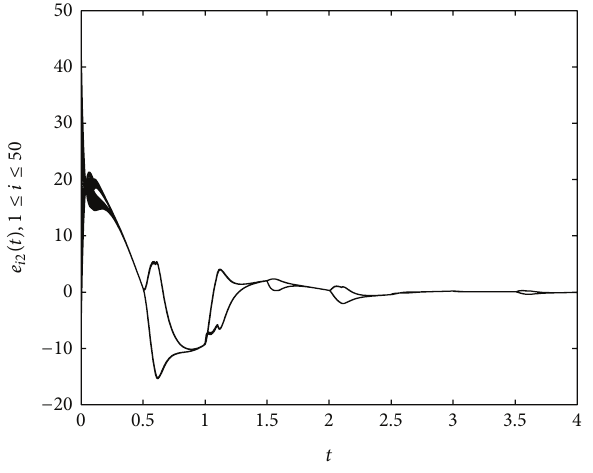
Figure 8: Synchronization errors 𝑒 𝑖 1 , 1 ≤ 𝑖 ≤ 50, with control parameters 𝑘 = 5, 𝑇 = 0 . 5, and 𝜃 = 0 . 1.